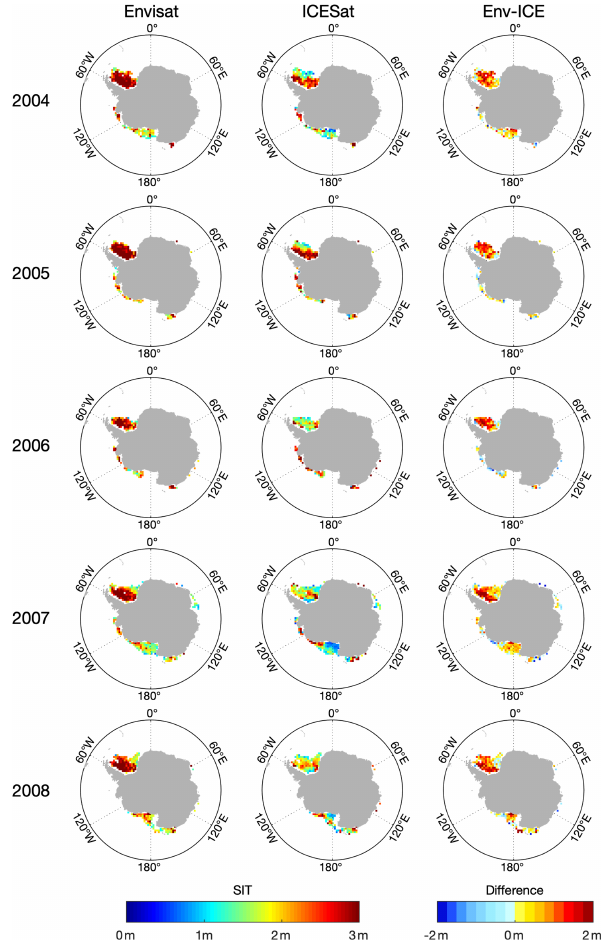
Figure 5. Same as Fig. 4 but for summer (February and